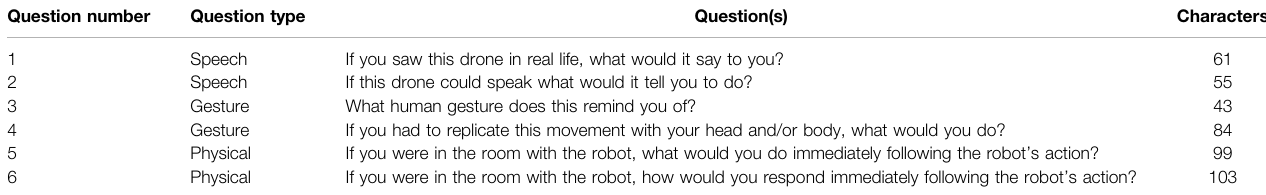
TABLE 2 | Study questions, with their anticipated response type, assigned number, and character length. Question number